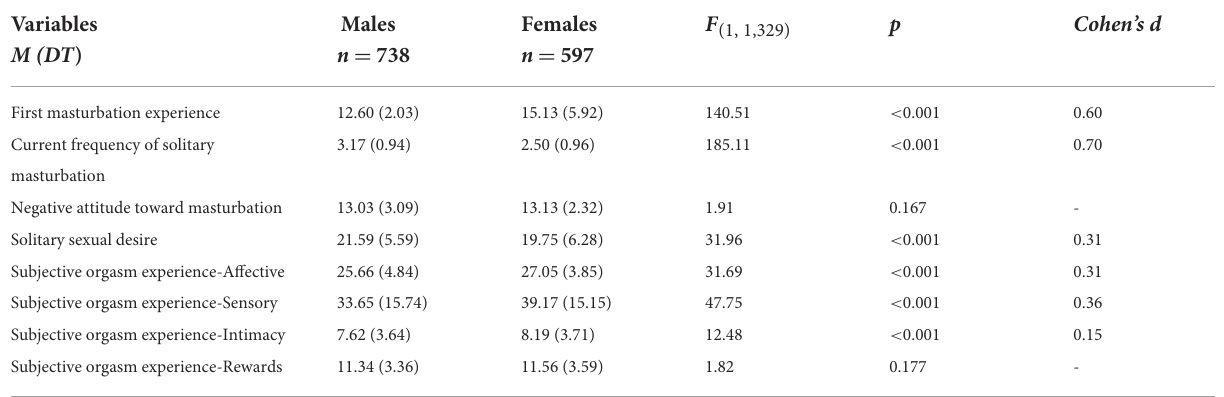
TABLE 2 Effects of sex on masturbation-related